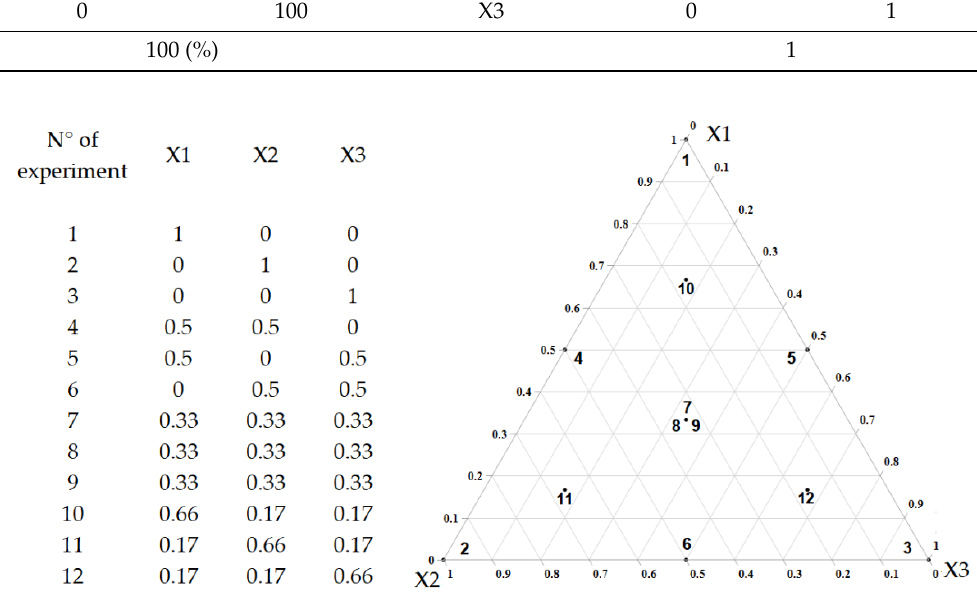
Figure 1. Illustration representing the augmented simplex-centroid design for three